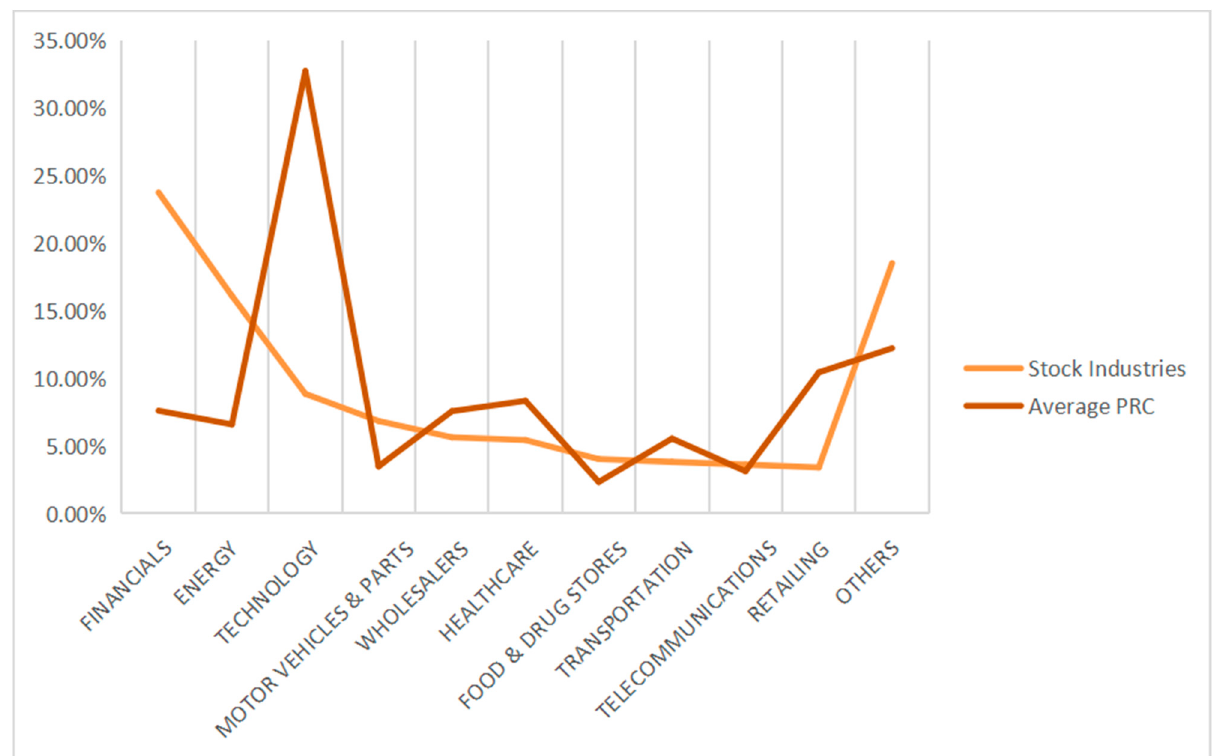
Figure 12. The evaluation of F1 score in industries.